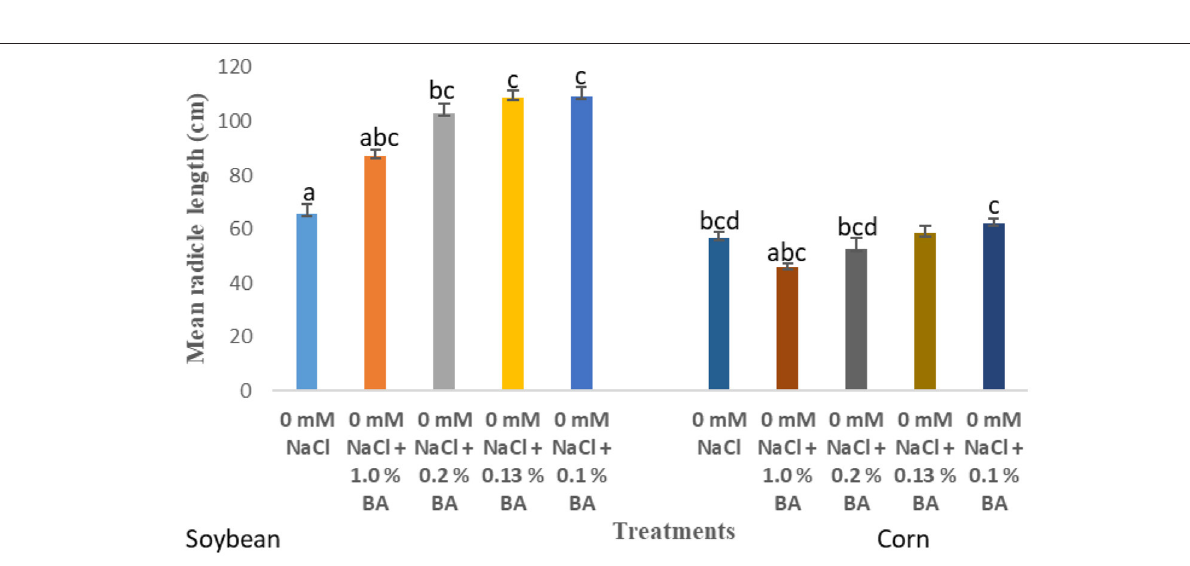
FIGURE 3 | Effect of treatment on the mean radicle length (cm) of corn and soybean under optimal conditions. Treatments with similar letters are not significantly different. Treatments with different letters are significantly